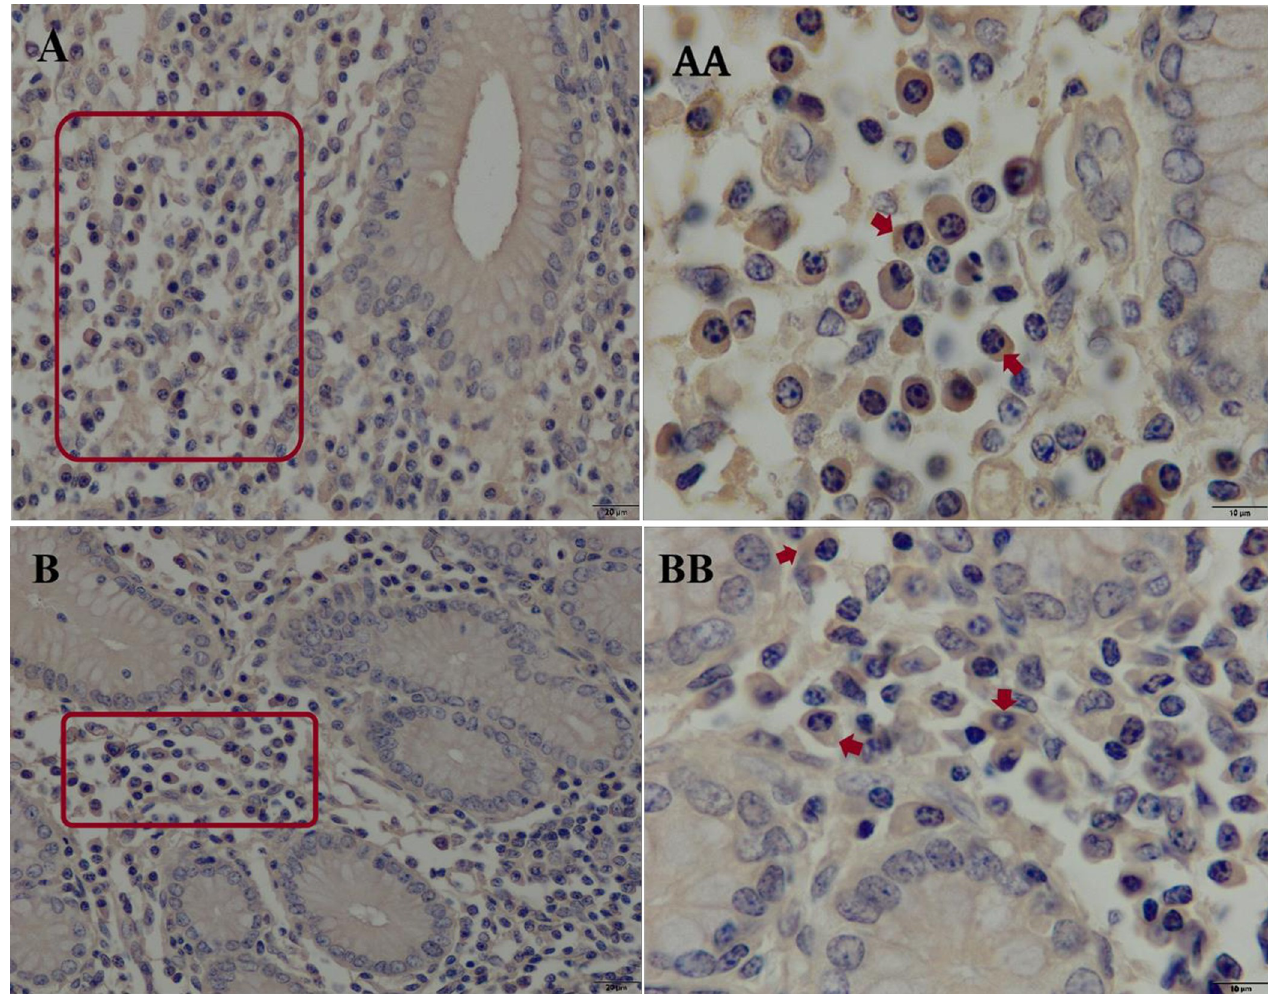
Fig 10. Immunohistochemical staining of IgA antibody-producing cells in the ALNA of young Dromedary camels. (A) Distribution of IgA APCs in longitudinal mucosal fold area; (B) Distribution of IgA APCs in reticular mucosal fold area. The IgA APCs were dispersed in the lamina propria among the gastric glands. Red rectangles are representative views from the two sublocations (Original magnification left column = 400 × , right column = 1000 × ).